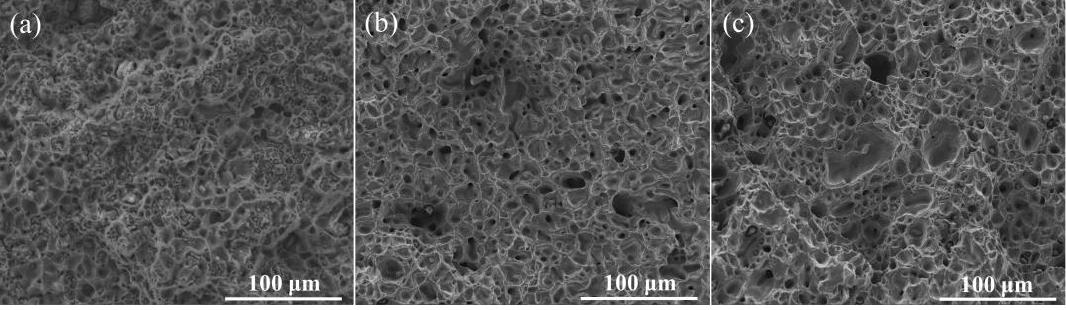
Figure 5. The fracture surface of the alloys: ( a ) VS; ( b ) PS; ( c ) PS0.5.